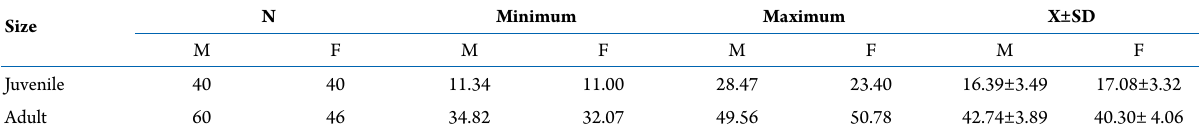
Table 1. Carapace width (mm) of Dilocarcinus pagei for males and females used in the experiment. N = Number of individuals; M = male; F = female; X = mean; SD = standard deviation.